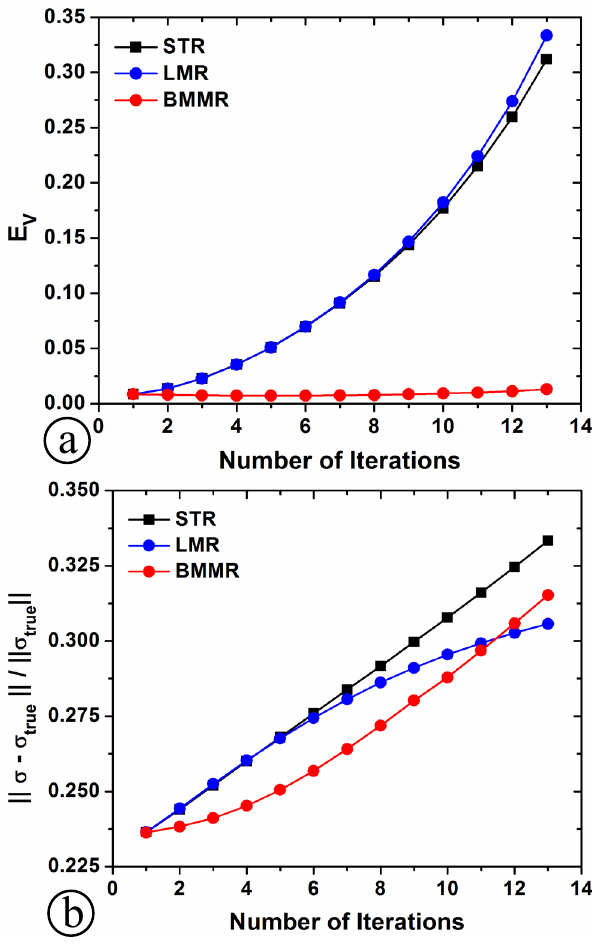
Fig.4: Error in different regularization methods for λ = 0.01: (a) normalized projection errors, (b) normalized solution error norm.